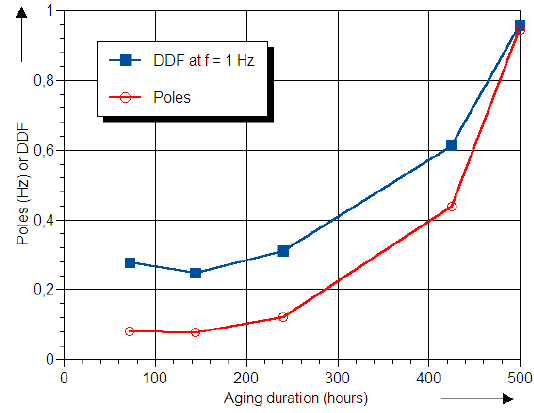
Figure 10. The DDF at f = 1 Hz and poles, as a function of frequency. The aging duration acted as parameter.